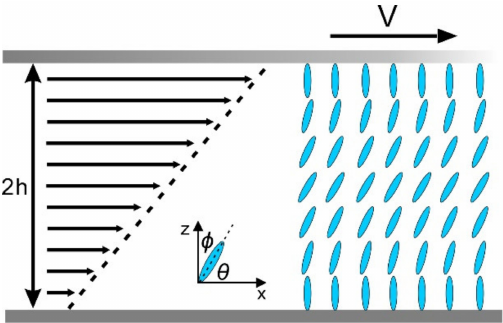
Figure 1. Schematics and description of the mathematical model of a nematic liquid crystal in the Couette flow. The upper plate is moved to the right at a constant